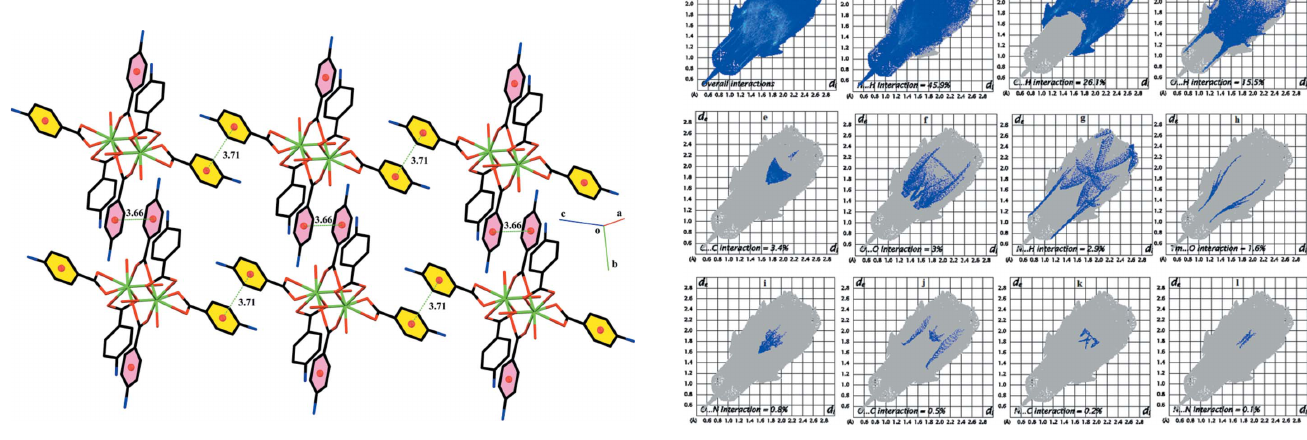
Figure 6 Two-dimensional fingerprint plots of 4ABA-Tm for ( a ) all interactions and ( b )–( l ) individual interatomic